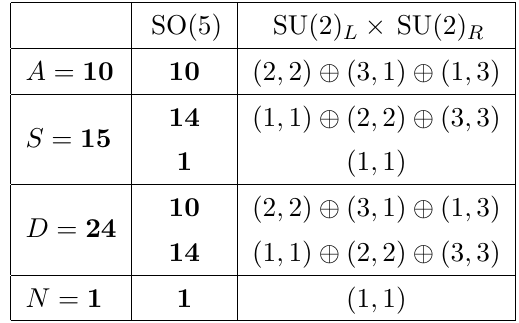
Table 1 . List of SU(5) spurions and their decomposition under SO(5) and the custodial SU(2) L (cid:2) SU(2) R symmetry. The left-handed doublet q L can be associated to any of the bi-doublets (2 ; 2), while the right-handed singlet t c can be associated to singlets (1 ; 1) or to the SU(2) R triplets (1 ; R